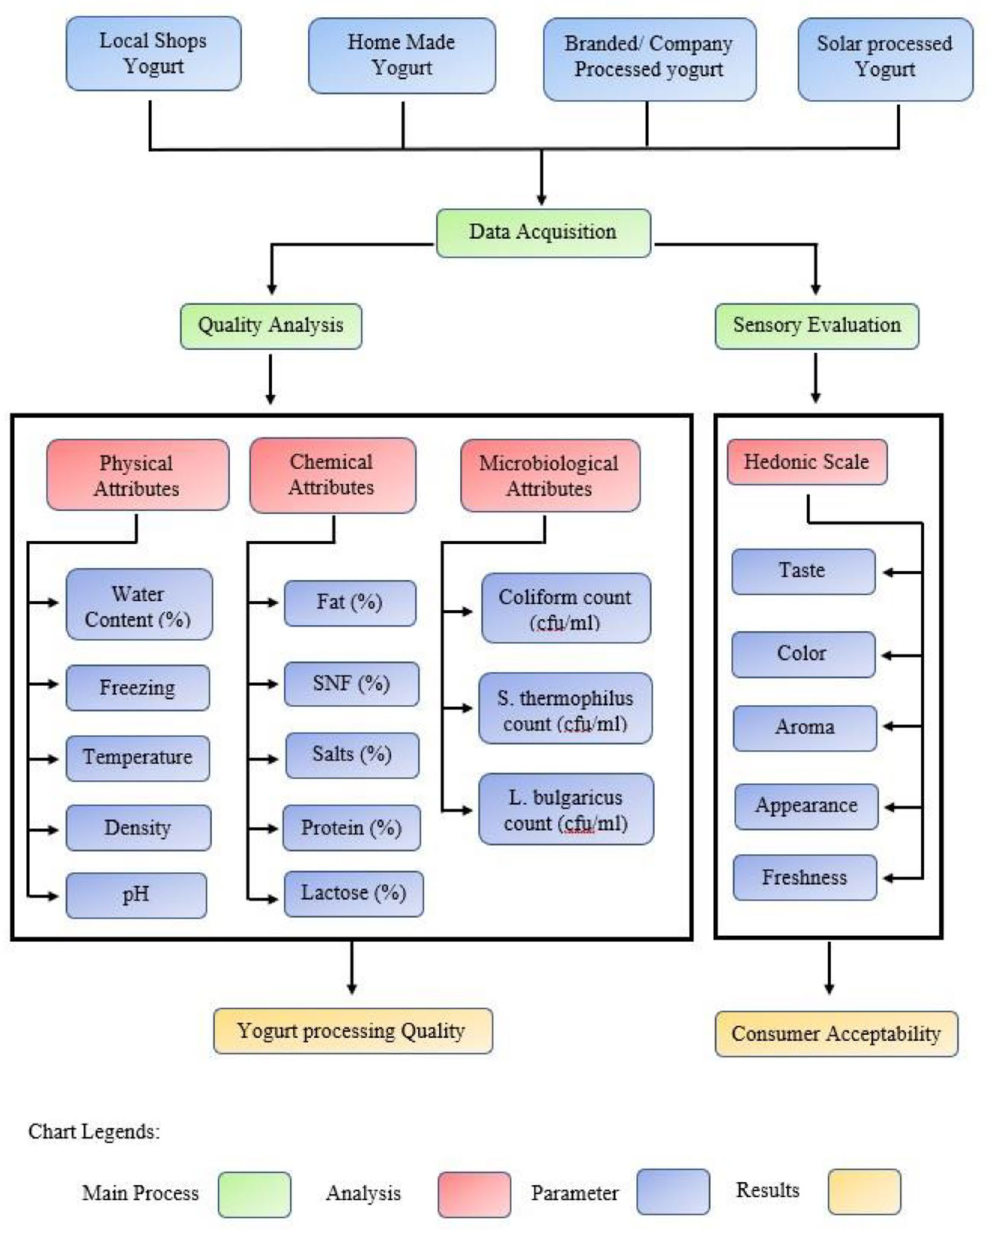
Figure 3. Flowchart of research